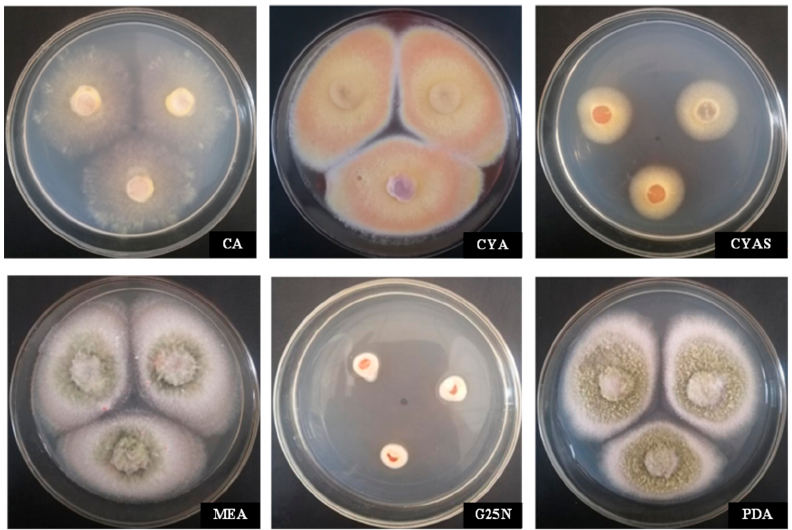
Figure 1. Morphological characteristics of the cultures of MR‑16 on six differential media. The front side of the colony was cultured on CA, CYA, CYAS, MEA, G25N, and PDA at 25 °C in the dark for 10 days.